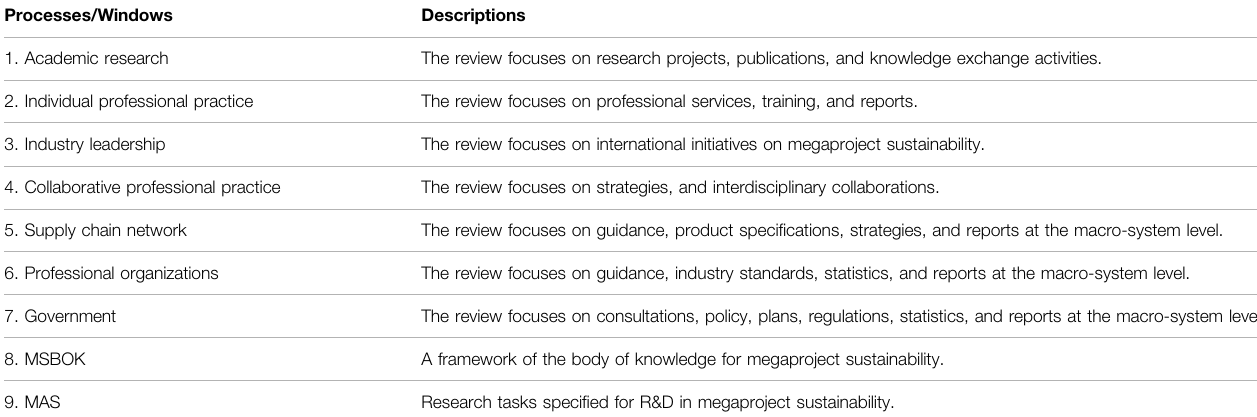
TABLE 2 | An overview of nine processes/windows for